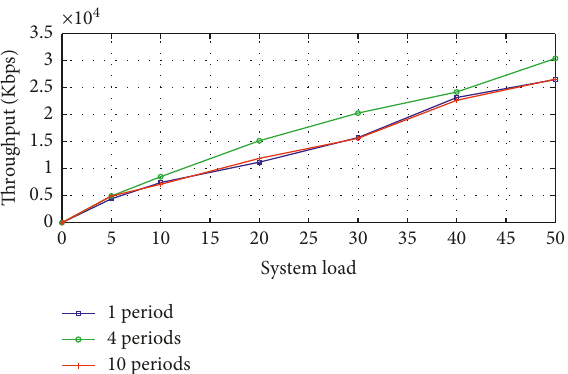
Figure 6: Call blocking probability (thunderstorm rain).